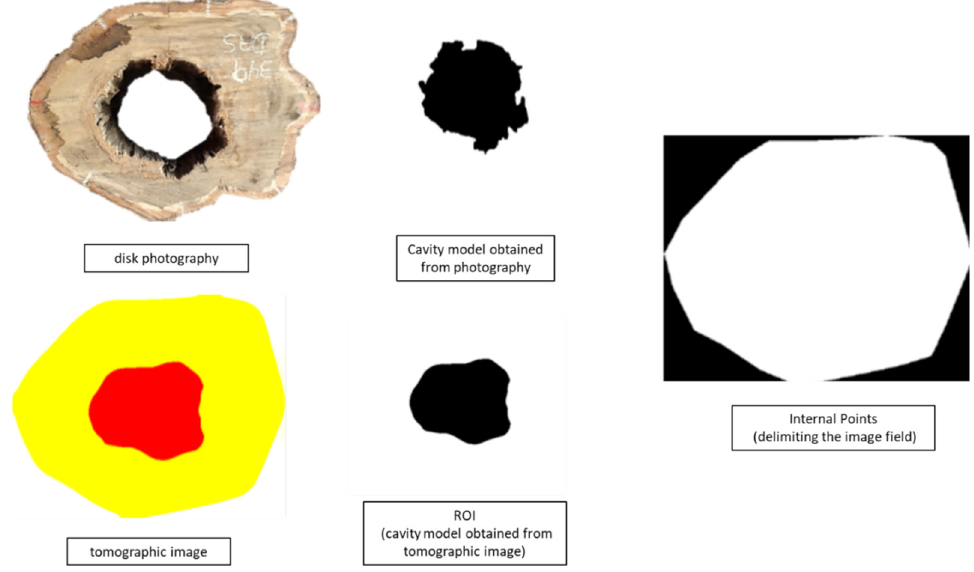
Figure 5. Example of images used in the confusion matrix to calculate the metrics.